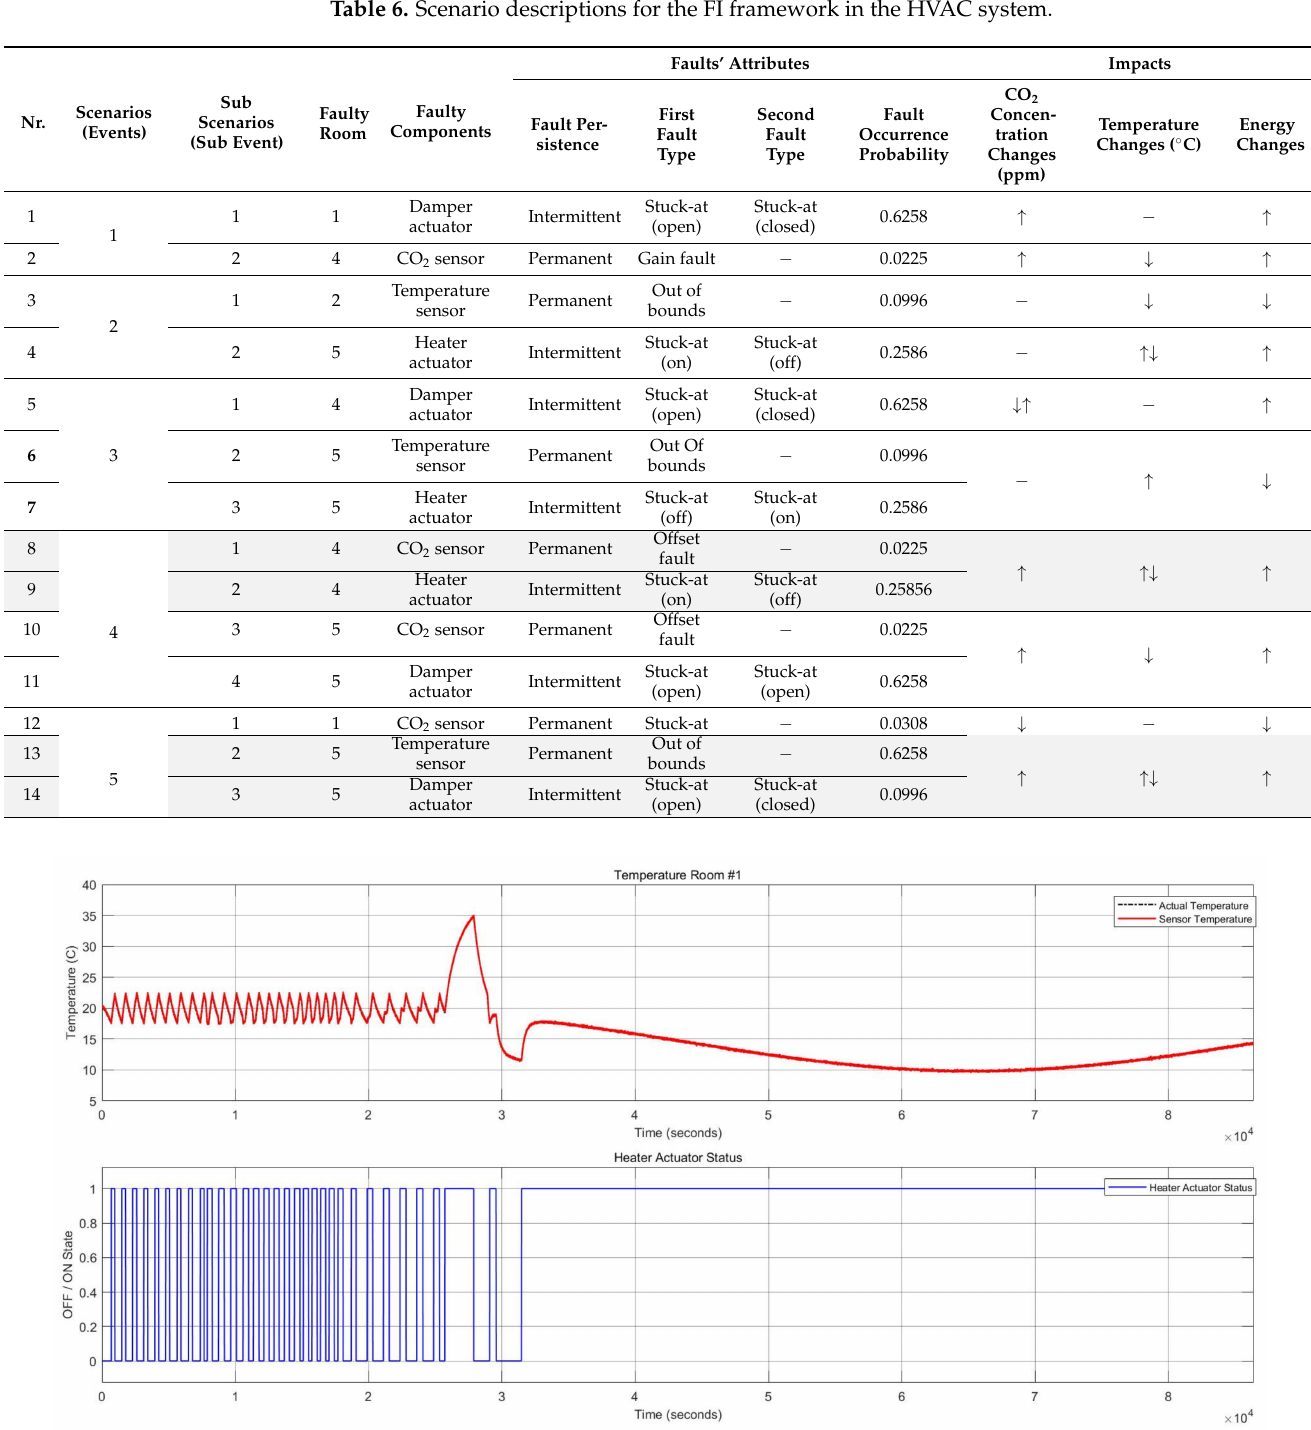
Figure 9. Thermal conditions for the heater actuator and CO 2 sensor